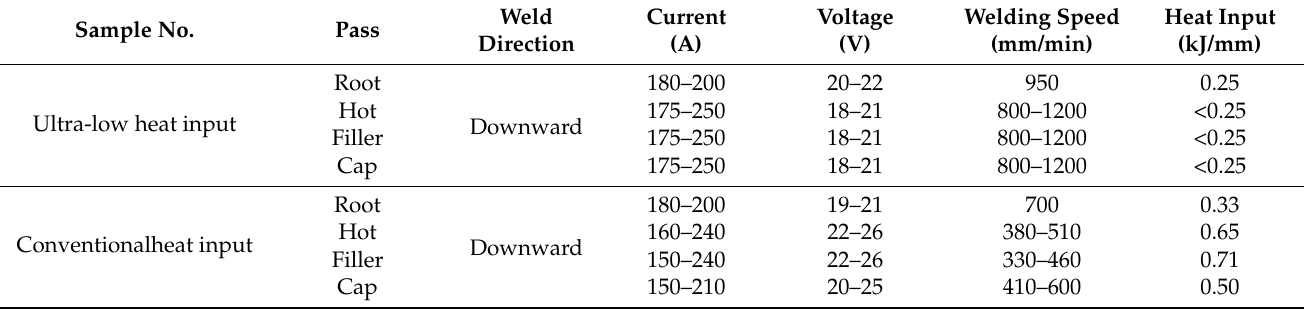
Table 3. Two different heat input automatic circumferential seam welding process parameters.